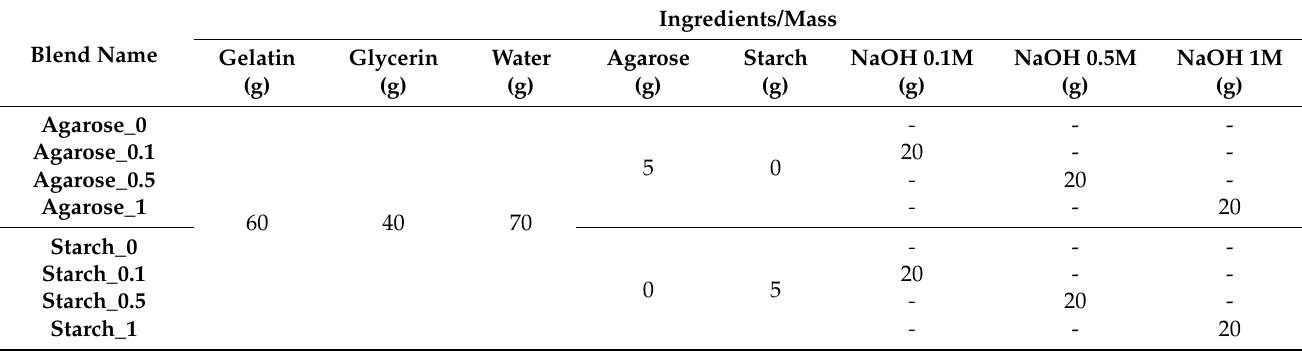
Table 8. Components used in compositions. Amounts are presented in parts by weight.